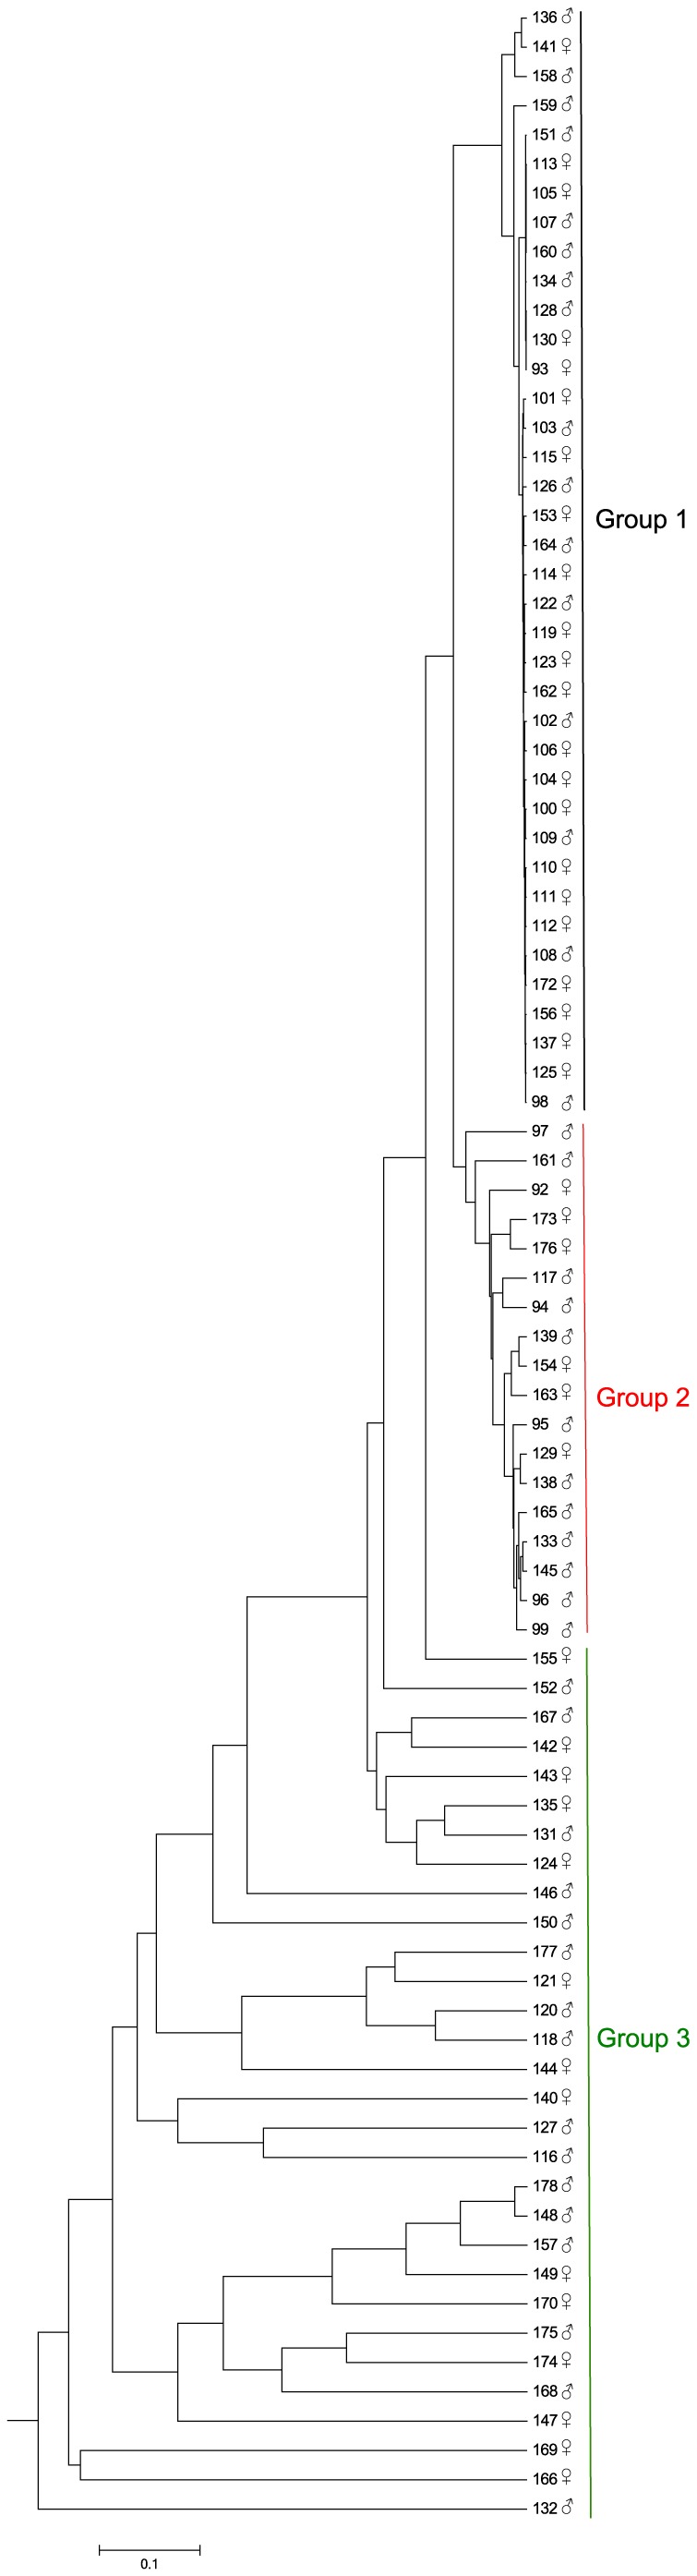
Dendrogram analysis based upon ThetaYC index of bacteria found on the skin of the 86 brook charr individuals.Groups are defined with the Weighted Unifrac distance. The first and second groups are composed of closely related bacterial communities. The third group is an assemblage of dissimilar communities and is considered as an outgroup. The most differentiated groups are groups 1 and 3 (Unifrac Score: 0.710811, p<0.0010) followed by the distance between groups 2 and 3 (Unifrac Score: 0.685361, p<0.0010), and the distance between groups 1 and 2 (Unifrac Score: 0.401674, p<0.0010).